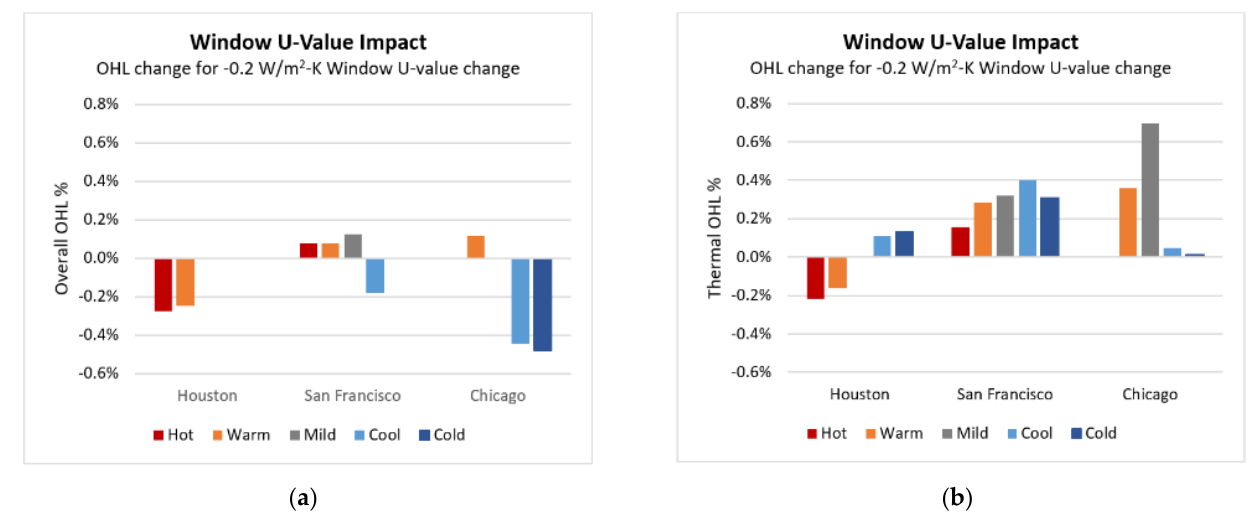
Figure 8. Impact of a 0.1 decrease in SHGC on overall ( a ) and thermal ( b ) OHL.